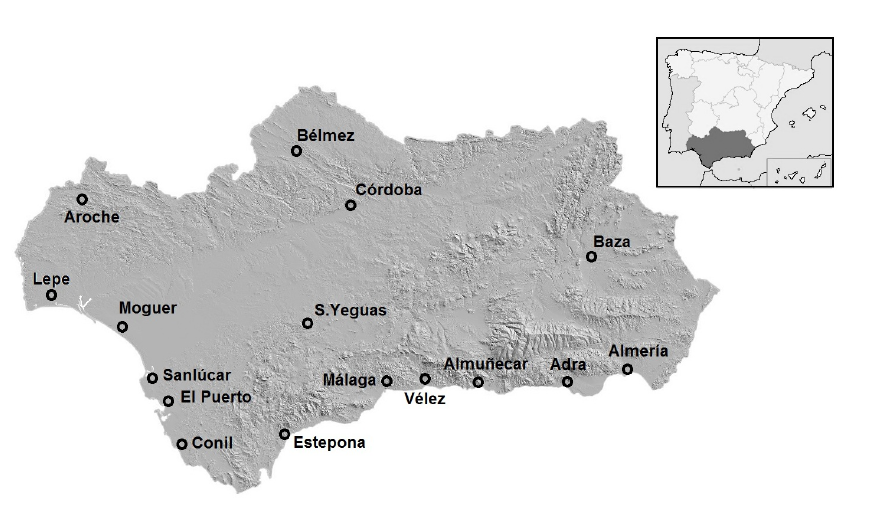
Figure A3. Geographic distribution of the sites considered in the study. 11 places are in the coastline of the region and 5 in the inner.